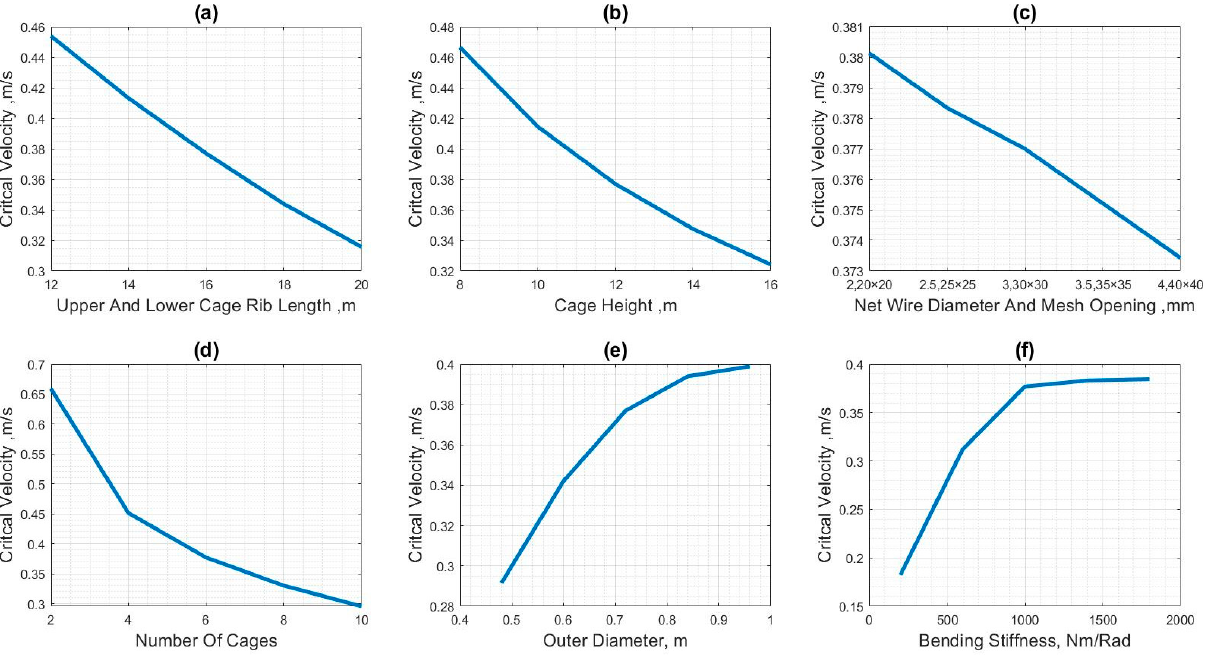
Figure 11. The critical buckling velocity for the Holding State as a function of: ( a ) the cage length (and width), ( b ) the cage height, ( c ) the net mesh, ( d ) the number of cages, ( e ) the outer diameter of the upper floatation pipe and ( f ) the connector spring stiffness.